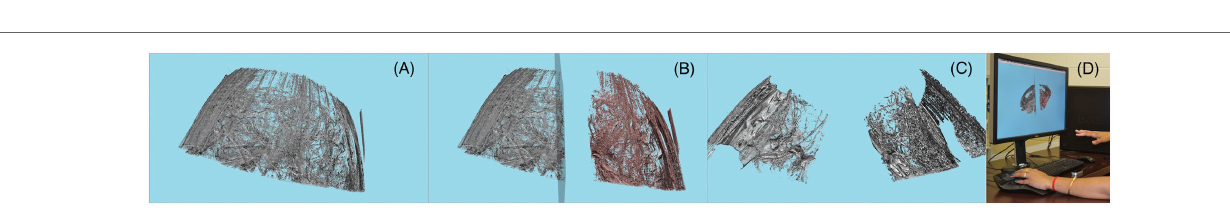
FigUre 1 | The bimanual-symmetric interface of the BhVc – (a) μ -cT scan, (B) cracking preview, (c) cracking, and (D) cracked data